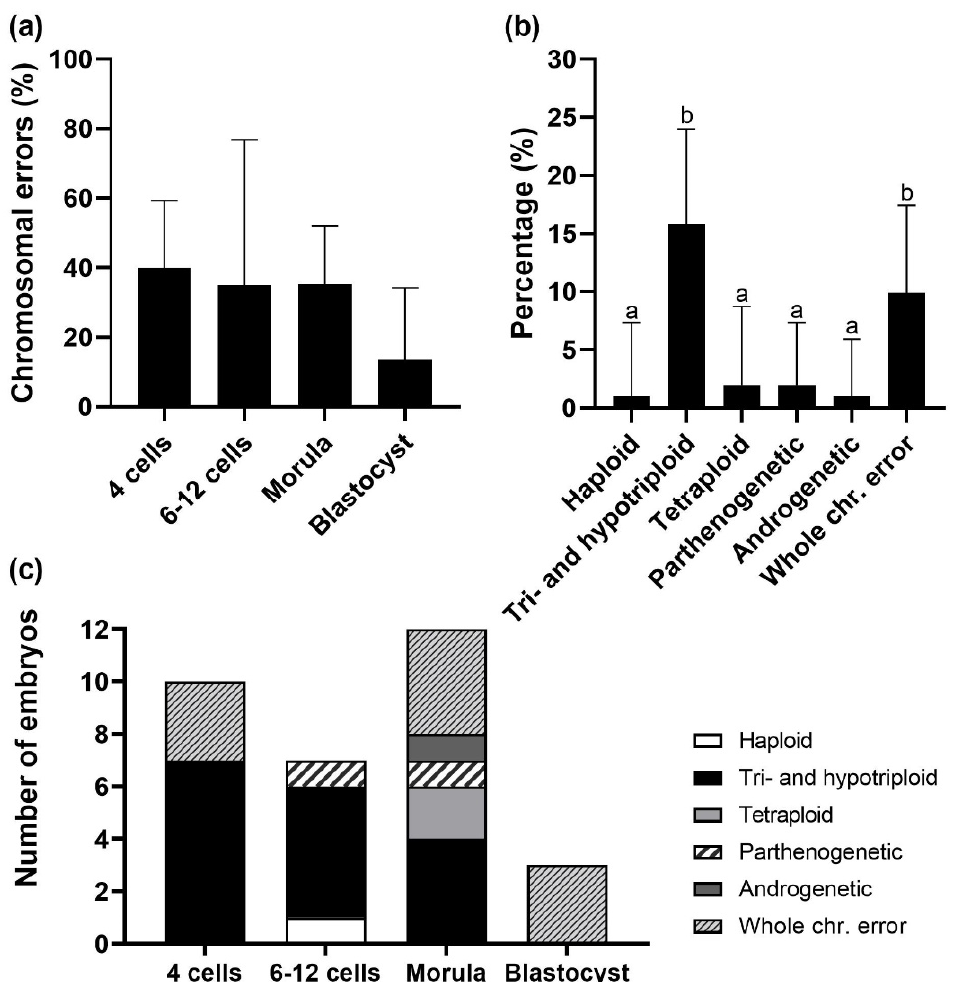
Figure 3. Chromosomal errors in IVD embryos ( n = 101) as identified by PGT-A. ( a ) Incidence of chromosomal errors at the different embryo developmental stages indicates a trend of fewer errors in blastocysts compared to the 4-cell stage ( p = 0.056); ( b ) A significantly higher incidence of triploid embryos and embryos with an individual whole chromosome (chr.) error (aneuploidy) was found compared to the other aneuploidy classes; ( c ) Number of embryos for each aneuploidy class per embryo development stage. Data presented as percentage (%) with 95% CI. Bars with different superscripts (a, b) denote significant difference ( p ≤ 0.05).